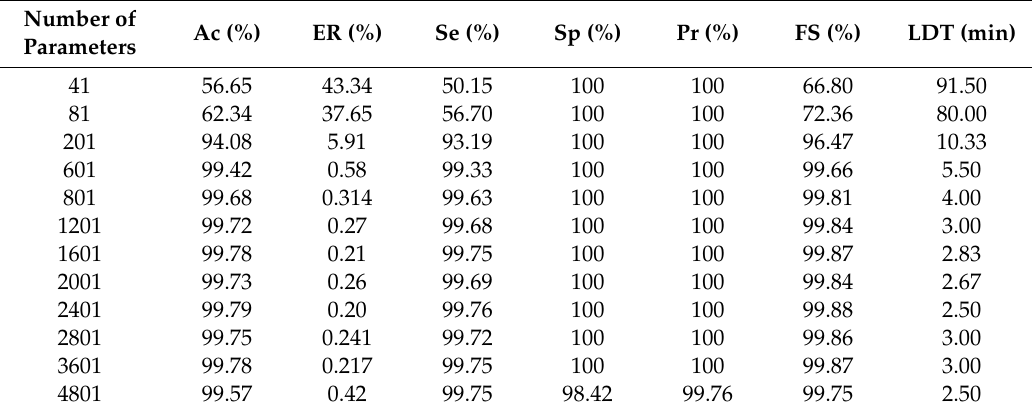
Table 6. Leak detection system performance measures with several parameters at 70 km, leak size was 5% of the nominal flow and, noise ratio was